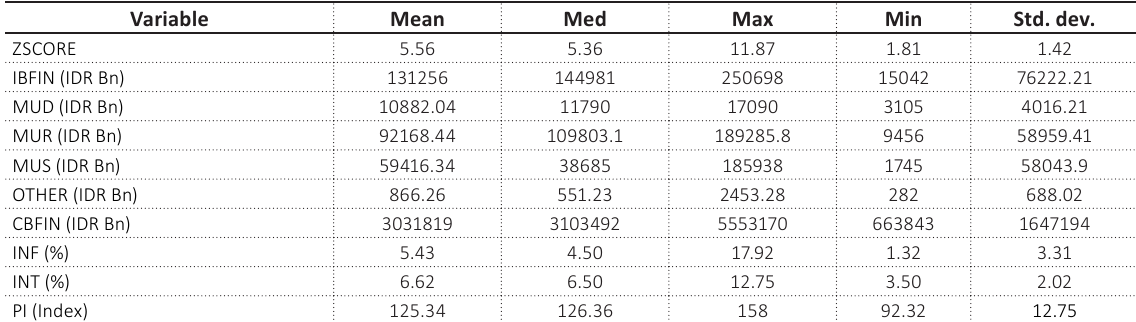
Figure 1. Islamic financing based on underlying contracts (in IDR billion)